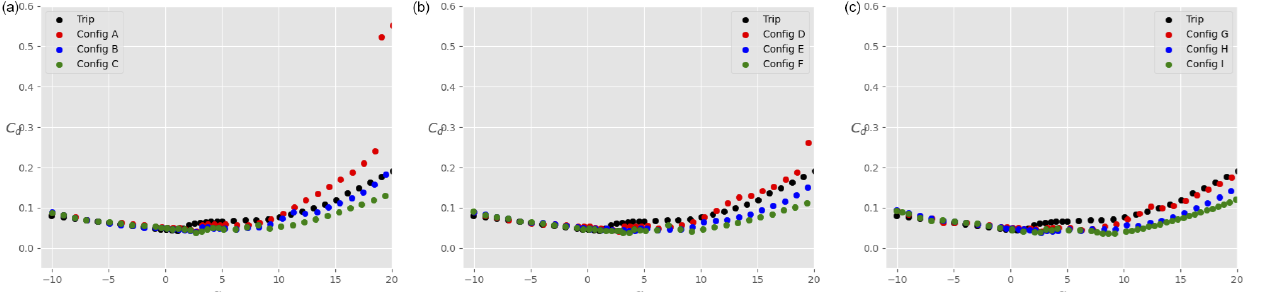
Figure 13. Total drag coefficient C d on the ensemble airfoil + slat as a function of the angle of attack α for different slat configurations, a tripped main airfoil, and Re = 1 . 5 × 10 6 : h slat /c main = 0 . 02 (a) , h slat /c main = 0 . 03 (b) , and h slat /c main = 0 . 04 (c) . The black data are taken without slat, while the coloured data are in the presence of a slat with β slat = 16 . 4 ◦ (red), β slat = 21 . 4 ◦ (blue), and β slat = 26 . 4 ◦ (green).